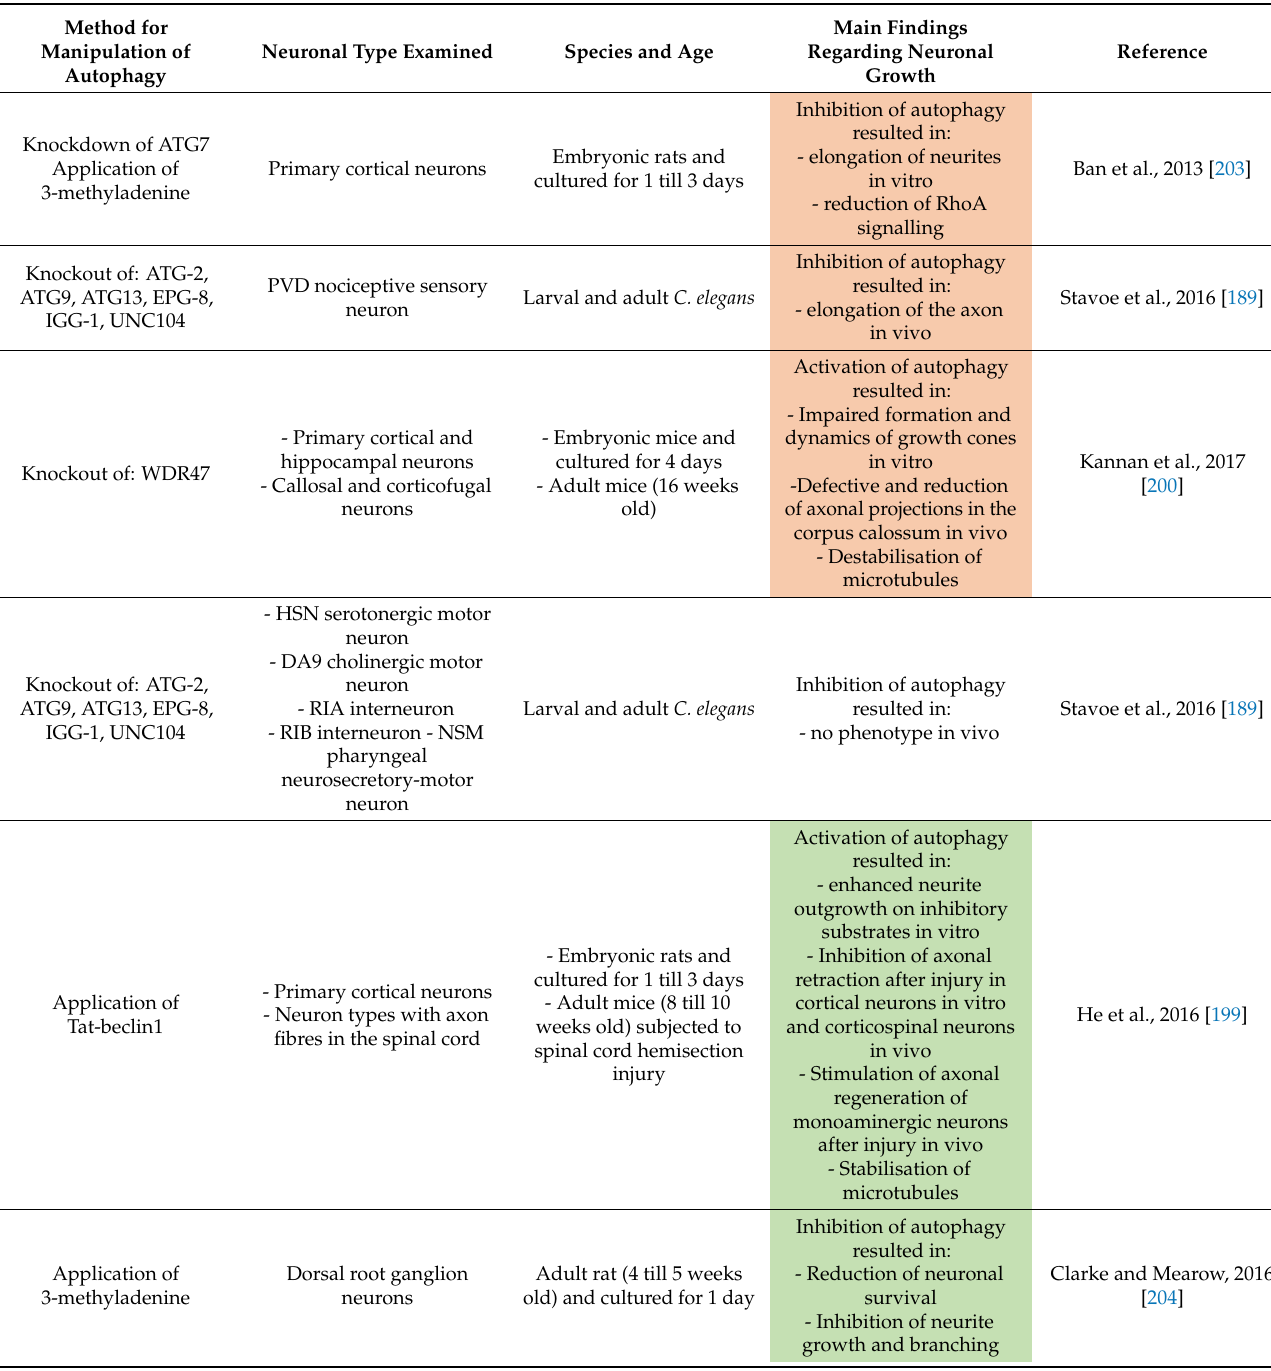
Table 1. Summary of studies that assessed the effect of autophagy on neuronal